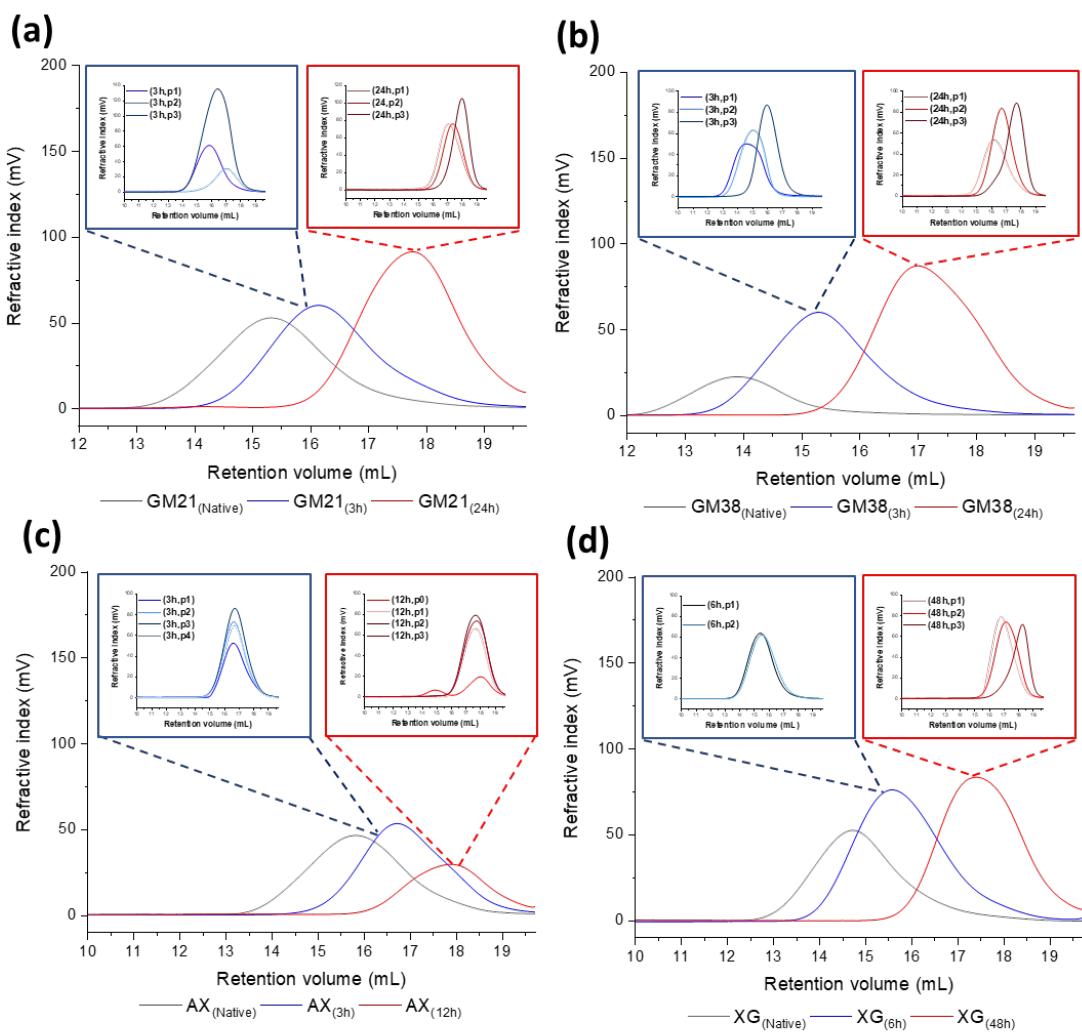
Figure 6. MWD plots measured by high- performance size exclusion chromatography (HPSEC) (OMNISEC) of native and partially hydrolyzed (OMNISEC) of native and partially hydrolyzed polysaccharides. ( a ) GM21 (Native) , GM21 (3h) , and GM21 (24h) ; ( b ) GM38 (Native) , GM38 (3h) , and GM38 (24h) ; ( c ) AX (Native) , AX (3h) , and AX (12h) ; ( d ) XG (Native) , XG (6h) , and XG (48h) . The inserts (blue and red boxes) shows the MWD plots of the isolated fractions of hydrolyzed samples after precipitation with i -PrOH.